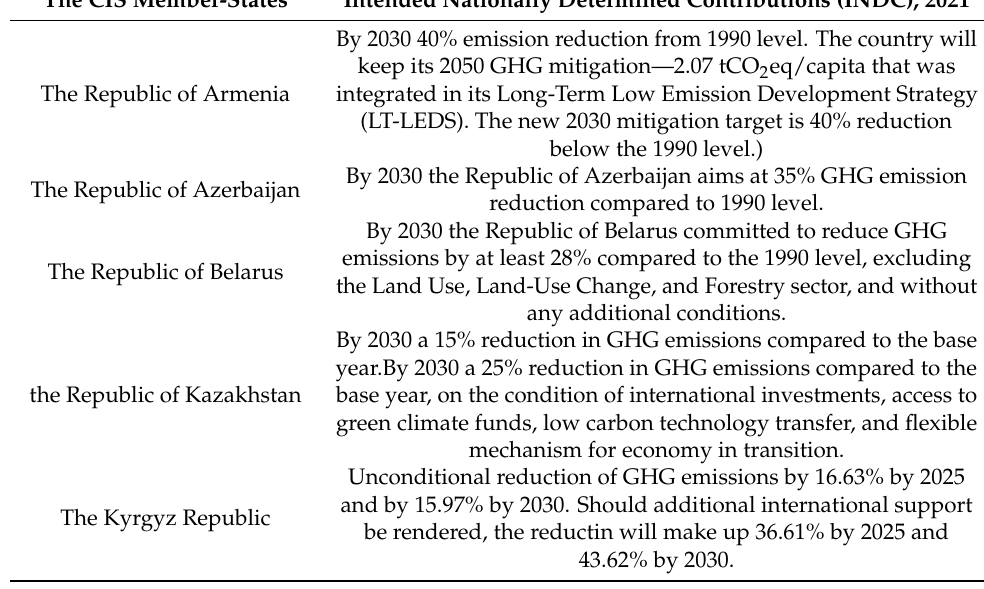
Table 2. Intended Nationally Determined Contributions of the CIS countries,